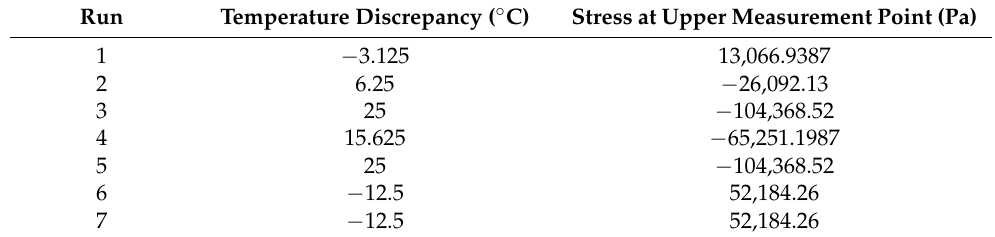
Table 1. Samples based on one-factor design.